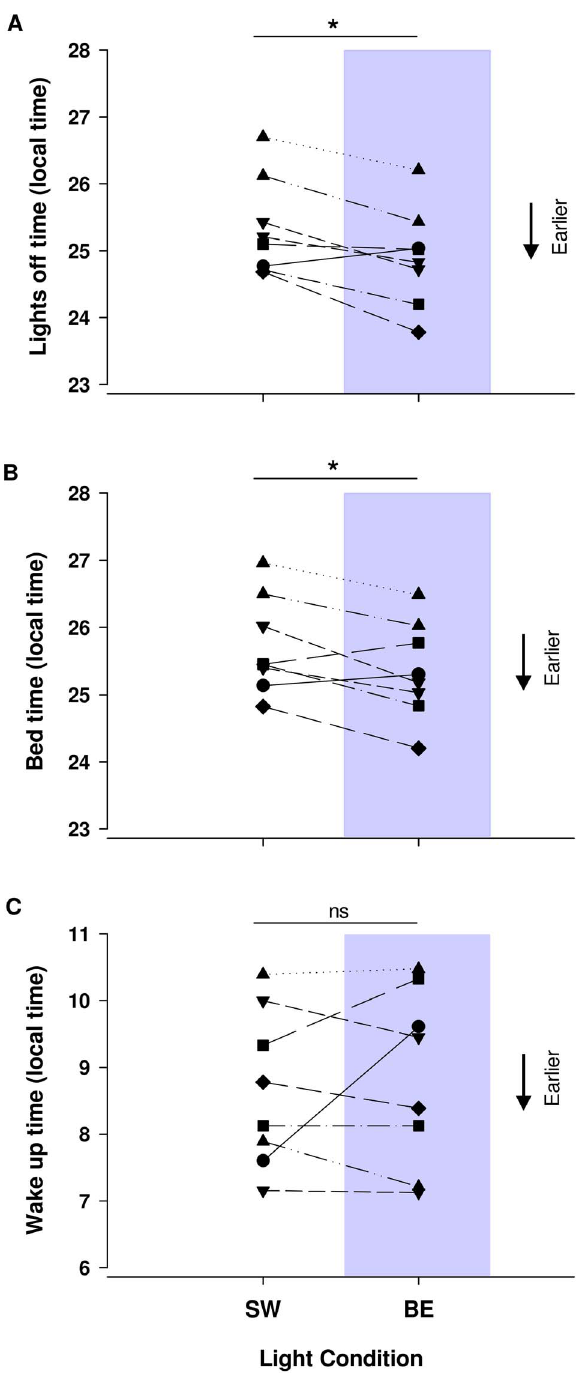
Figure 3. Impact of SW and BE light on the participants’ lights off time and sleeping pattern. Average lights off time ( A ) and bed time ( B ) were significantly earlier under BE light weeks (24.9 6 0.3 h and 25.4 6 0.3 h, respectively) in comparison SW light weeks (25.3 6 0.3 h and 25.7 6 0.3 h, respectively) (p , 0.05). Wake up time was not significantly different between lighting conditions, 9.0 6 0.6 h and 8.6 6 0.4 h under BE and SW light respectively (p=0.4). doi:10.1371/journal.pone.0102827.g003 extreme environments, optimizing the intensity and spectral composition of ambient light is crucial for optimal physiological and behavioral functioning.